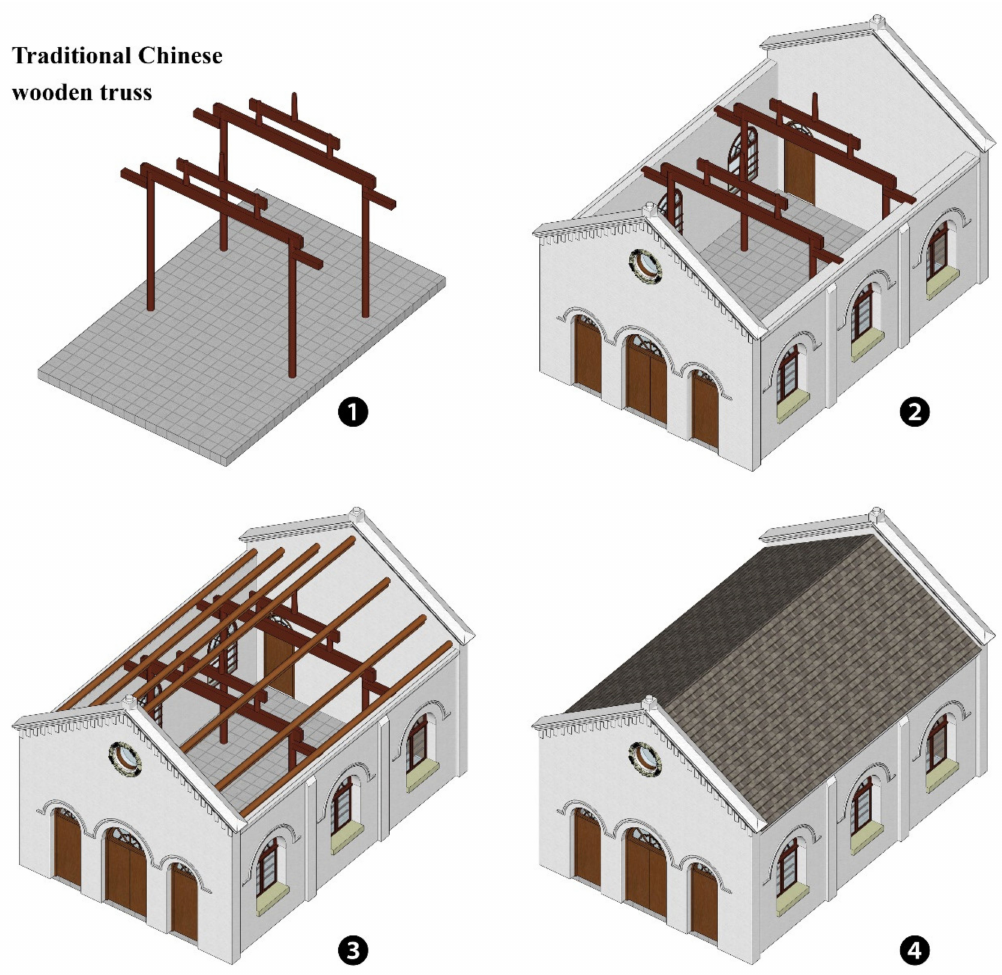
Figure 7. Diagram of the church.